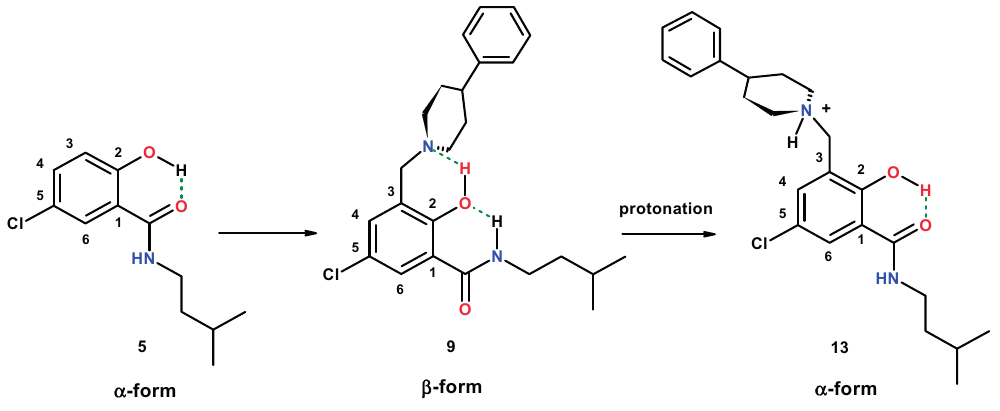
Figure 6. Reversal of the conformational switch in the hybrid of salicylamide-Mannich base 9 upon protonation of the Mannich base nitrogen, affording 13 (dashed lines: hydrogen